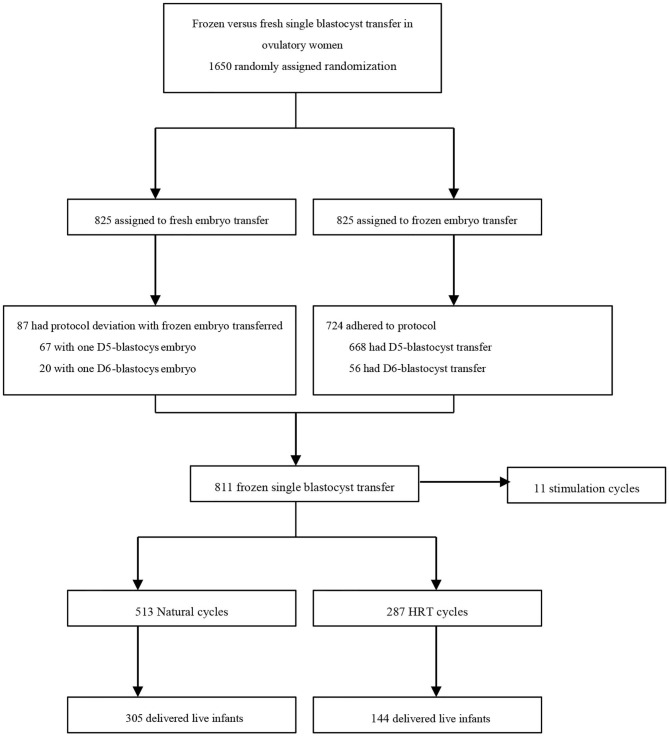
Study flow diagram.